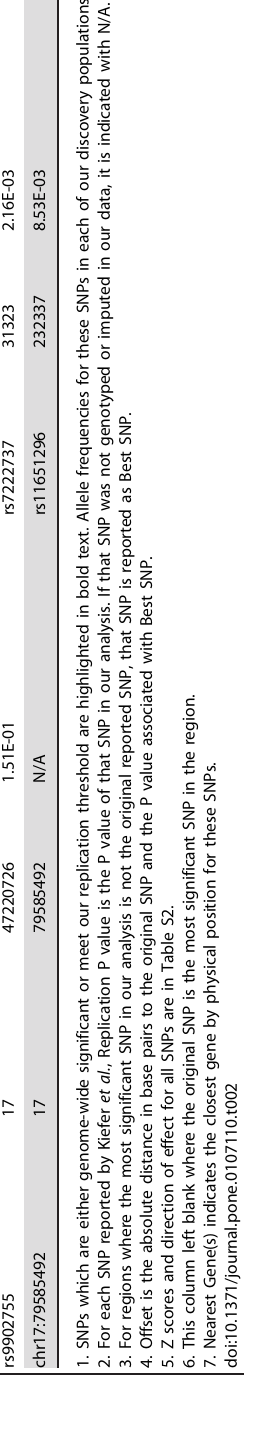
meta-analysis. The QQ plots of the meta-analysis p values (Figure 1a and Figure 2a) showed some deviation from the null.